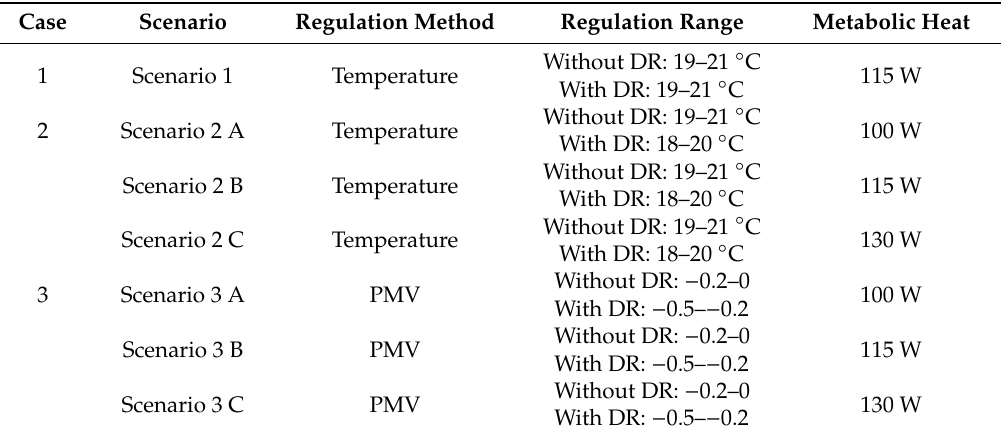
Table 4. Scenario description of case